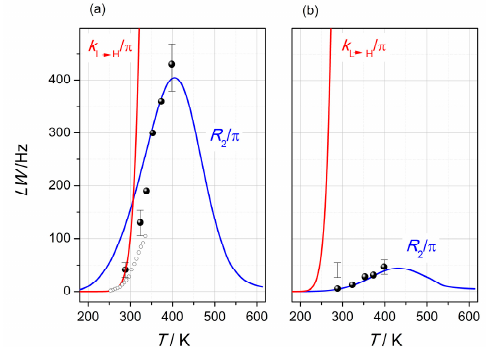
Figure 6. Temperature-dependent 1 H-NMR linewidths of proton H 1 ; filled symbols: 500 MHz; [D 5 ]nitrobenzene; open symbols: 400 MHz; [D 3 ]MeCN; blue lines: Model calculations of 1 H-NMR linewidths ( LW = R 2 / π ) in terms of Equation (2) ( Δ SCO H = 40 kJ·mol − 1 ; Δ SCO S = 80 J·(K·mol) − 1 ; C 0 = 40000 ppm·K; Arrhenius frequency factor: A 0(H → L) = 4 × 10 9 s − 1 ; 500 MHz); red line: temperature dependence of the ls relaxation rate constants k L → H / π (Arrhenius frequency factor: A 0(L → H) = 6 × 10 13 s − 1 ); ( a ) [FeL] (BF 4 ) 2 with E a = 22 kJ·mol − 1 ; ( b ) [Fe(tren)py 3 ] (ClO 4 ) 2 : E a = 12 kJ·mol − 1 .